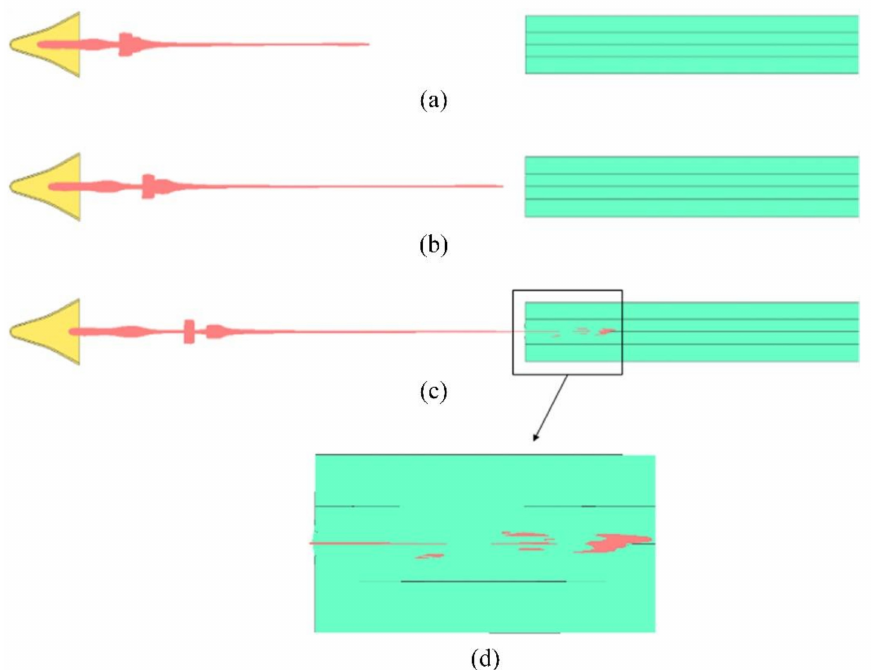
Figure 7. Numerical simulation results of the shaped charge jet directly penetrating the target. ( a ) Jet condition when t = 52.5 µ s; ( b ) Jet condition when t = 62.5 µ s; and ( c ) Jet condition when t = 77.5 µ s; ( d ) Jet head condition when t = 77.5 µ